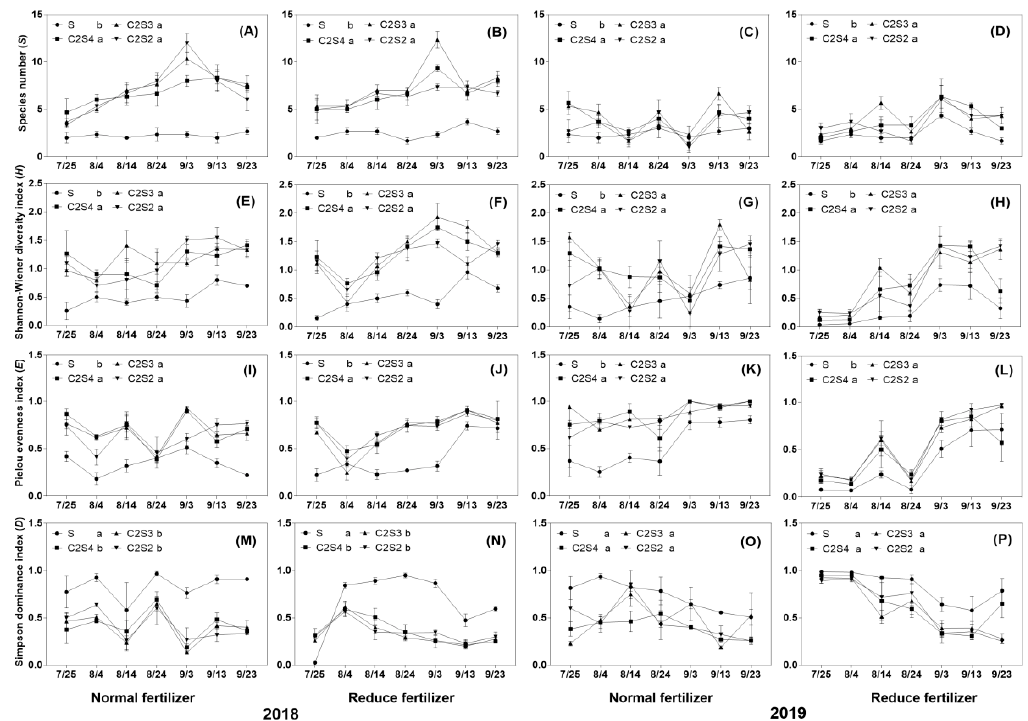
Figure 3. Community diversity indices of insects on soybean plants in 2018 and 2019 (Note: S : species number of insect; H : Shannon–Wiener diversity index; E : Pielou evenness index; D : Simpson dominance index; lowercase letters represent significant differences among different intercropping planting patterns by LSD test at p < 0.05; ( A, E, I, M ): S , H , E and D , respectively, of normal fertilizer in 2018; ( C, G, K, O ): S , H , E and D , respectively, of normal fertilizer in 2019; ( B, F, J, N ): S , H , E and D , respectively, of reduced fertilizer in 2018, respectively; ( D, H, L, P ): S , H , E and D , respectively, of reduced fertilizer in 2019).